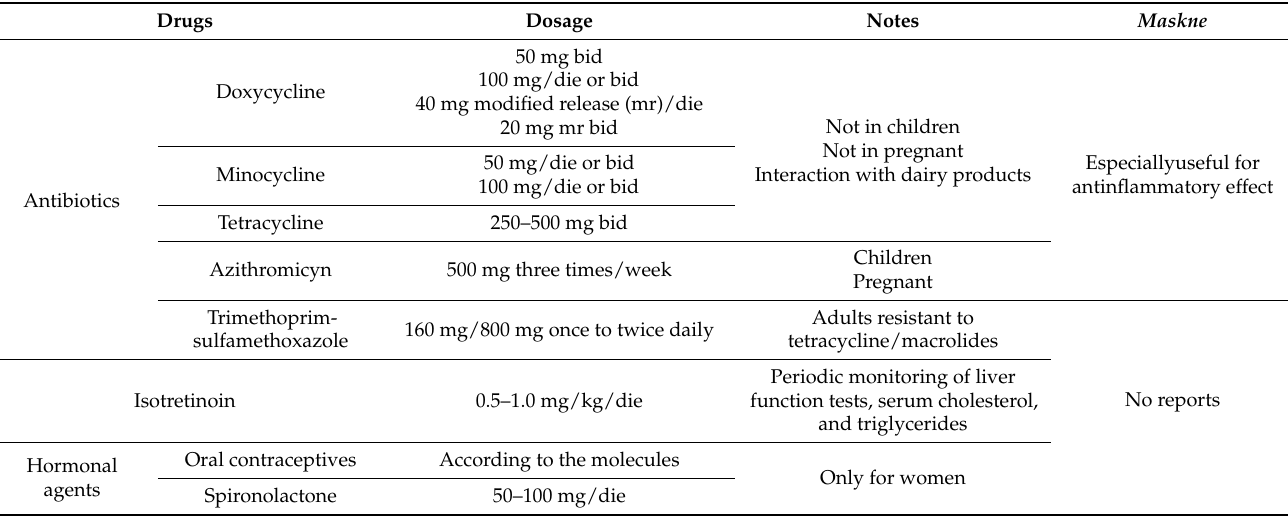
Table 2. Systemic therapies in